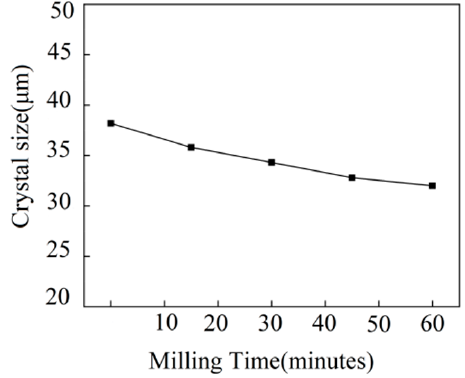
Figure 2. The characterization of brick powder.